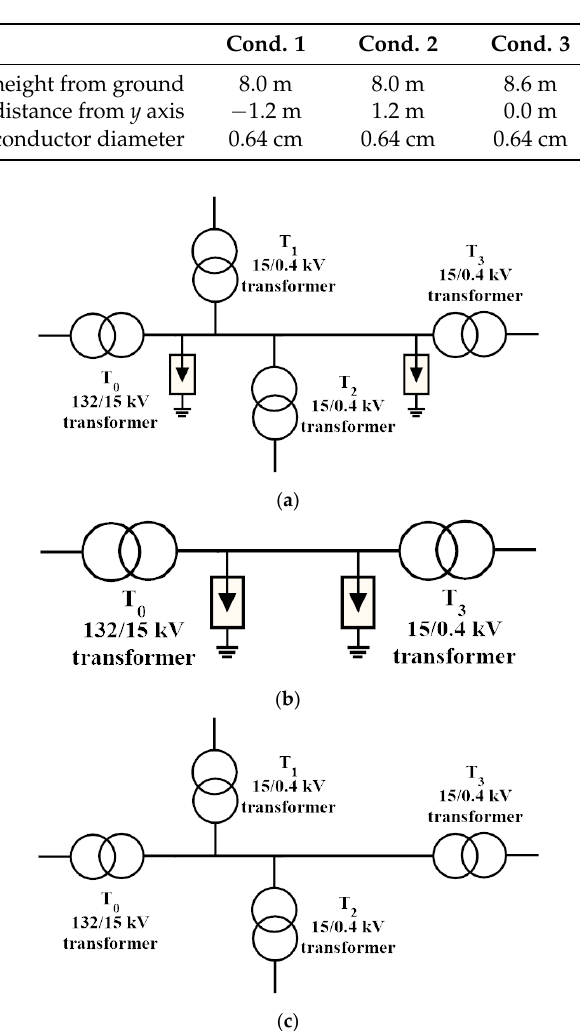
Figure 2. Distribution network topology for the three considered tests. Panels ( a – c ) show the networks for Test1, Test2, and Test3, respectively.